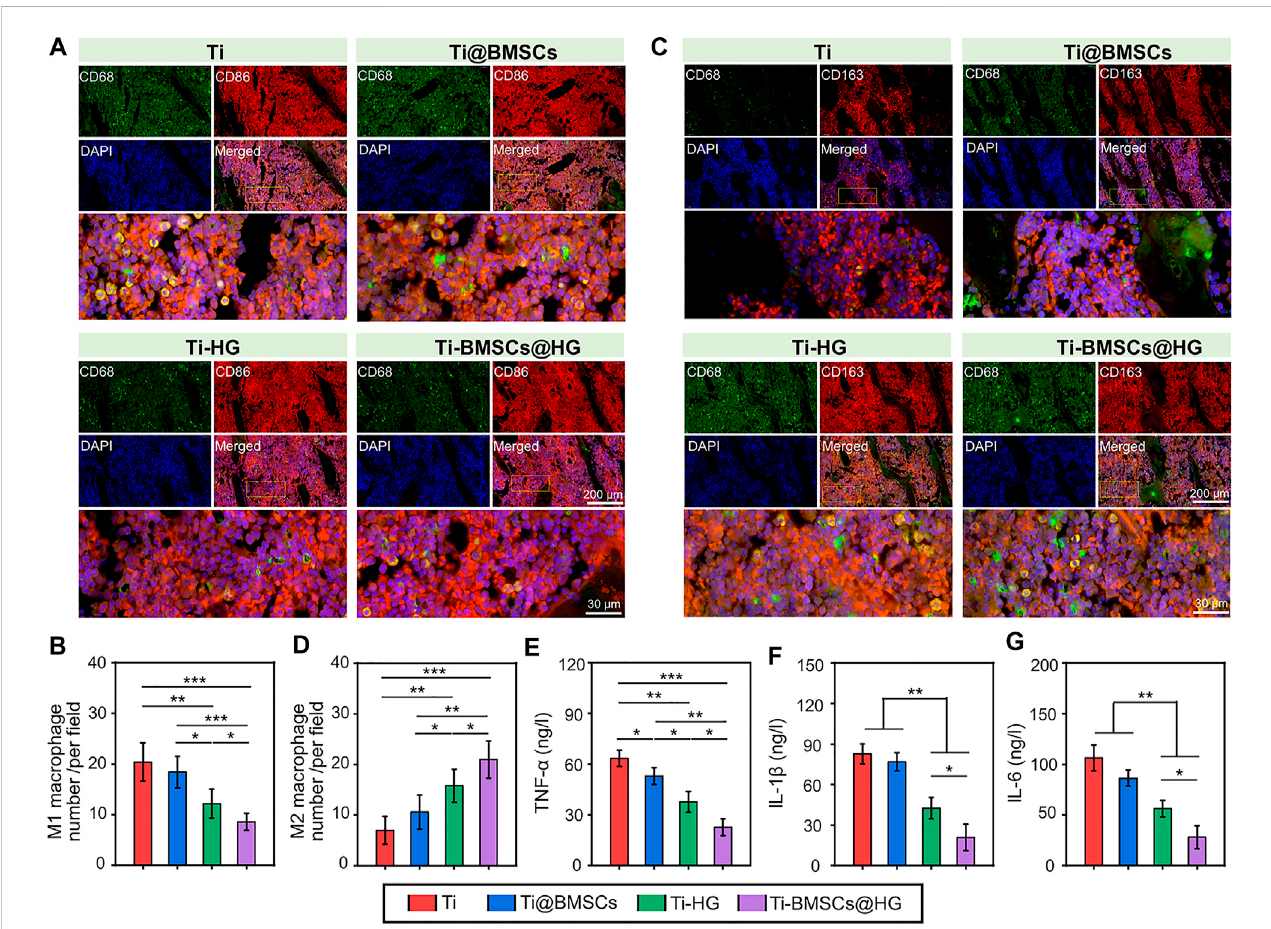
FIGURE 7 (A) Representative immuno fl uorescence staining images of CD68 plus CD86 to label M1 phenotype macrophages after implantation for 2 weeks. (B) Quantitative analysis of the number of M1 phenotype macrophages. (C) Representative immuno fl uorescence staining images of CD68 plus CD163 to label M2 phenotype macrophages after implantation for 2 weeks. (D) Quantitative analysis of the number of M2 phenotype macrophages. (E – G) The concentrations of TNF- α , IL-1 β , and IL-6 in bone marrow blood around the prosthesis interfaces (* p < .05, ** p < .01, and *** p <